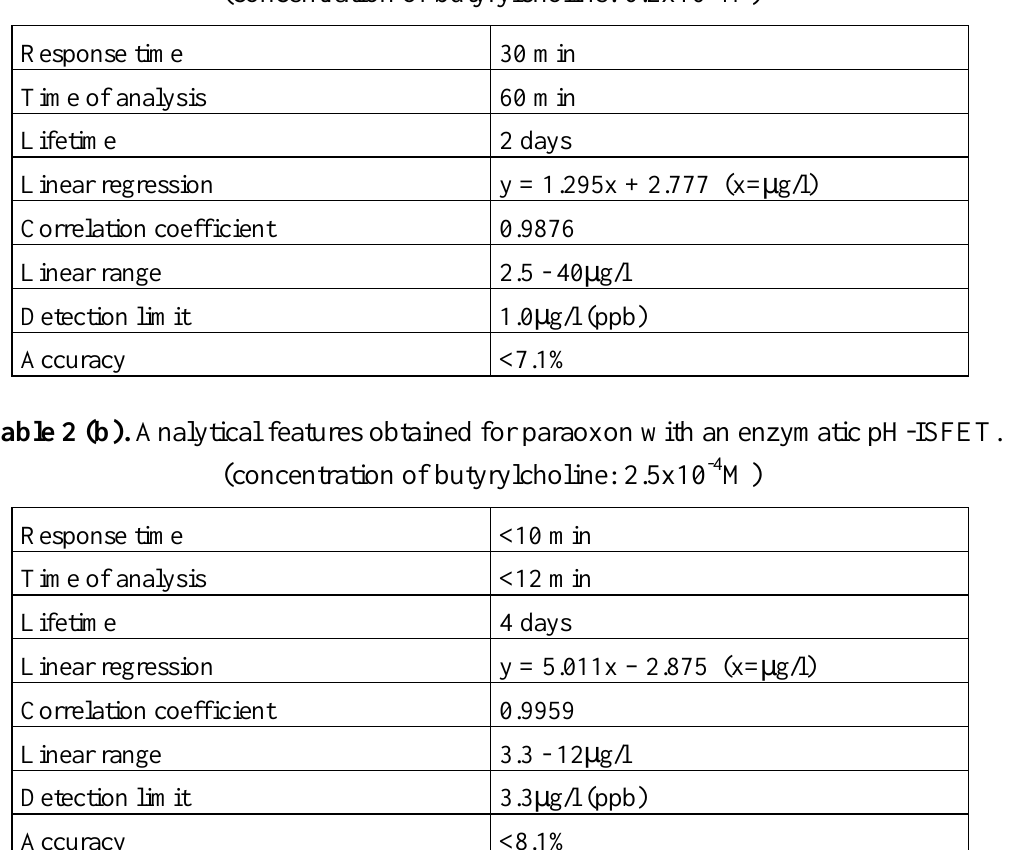
Table 2 (a). Analytical features obtained for paraoxon with an enzymatic pH-ISE.